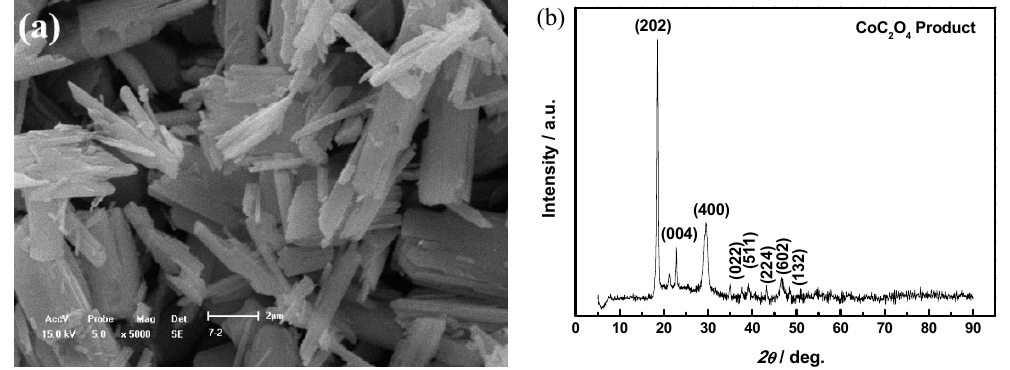
Figure 11. SEM ( a ) and XRD patterns ( b ) of cobalt oxalate product in a low concentration of cobalt solution.